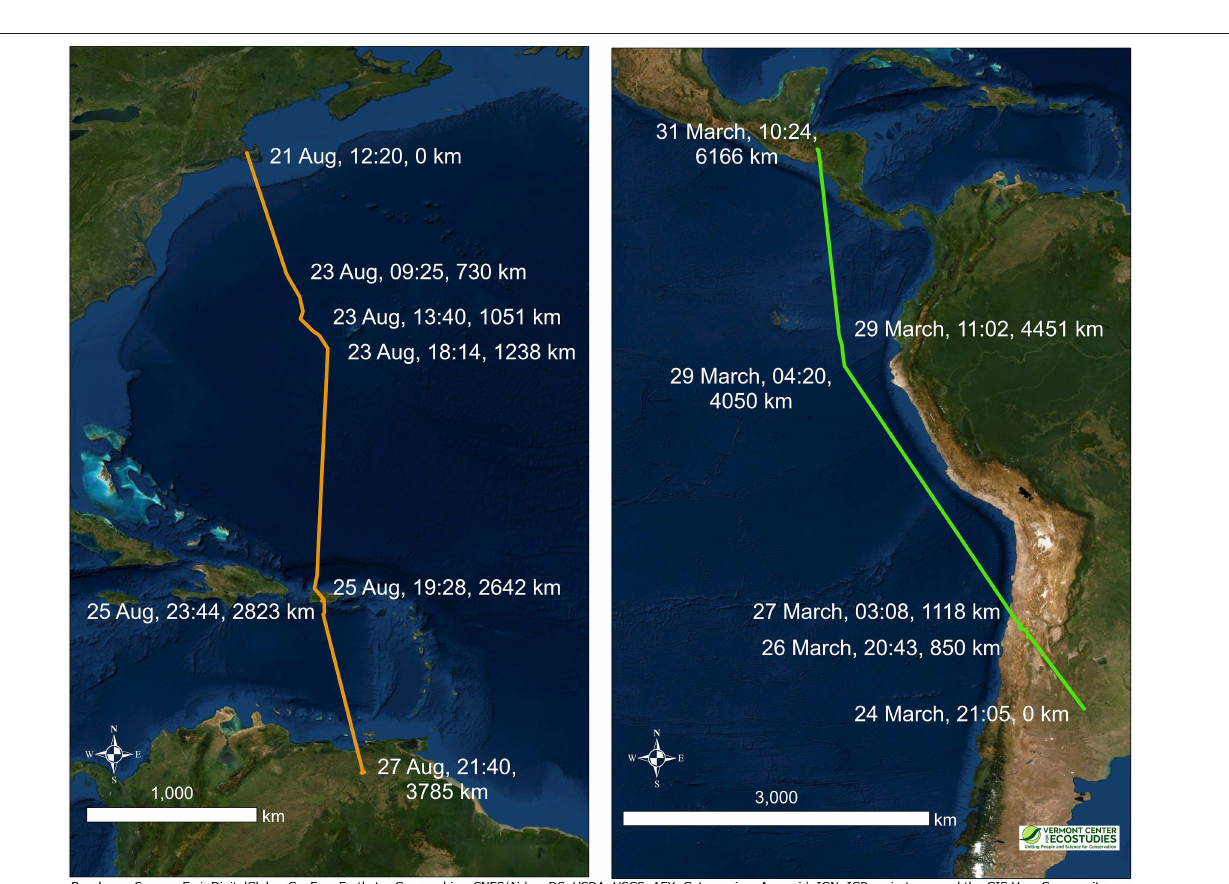
Distance to breeding (km)